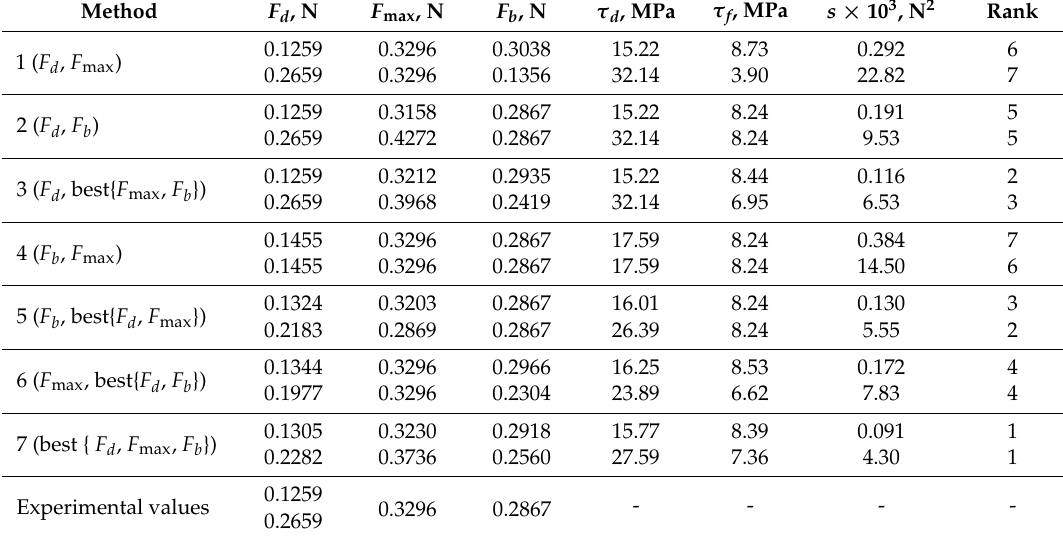
Table 4. Interfacial strength parameters determined from the experimental force–displacement curve for E-glass fiber–PP matrix pair using different